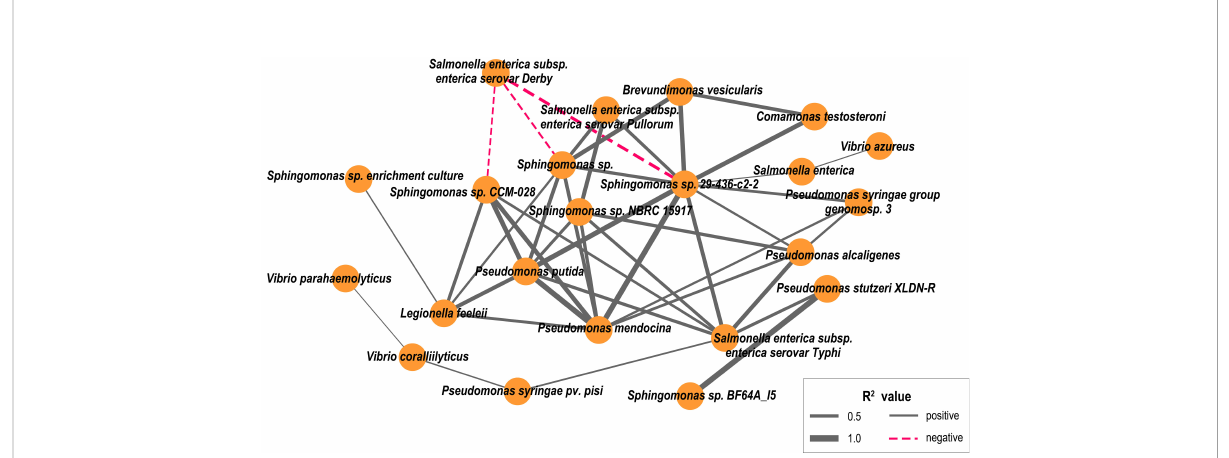
FIGURE 8 Connections between pathogenic bacteria indicate (p < 0.05) Spearman rank correlations between them. Line thickness re fl ects the strength of the correlation relationship between pathogenic species (R 2 value), and the line color re fl ects the relationship between pathogenic species, with positive correlations (solid line, gray) and negative correlations (dashed line,